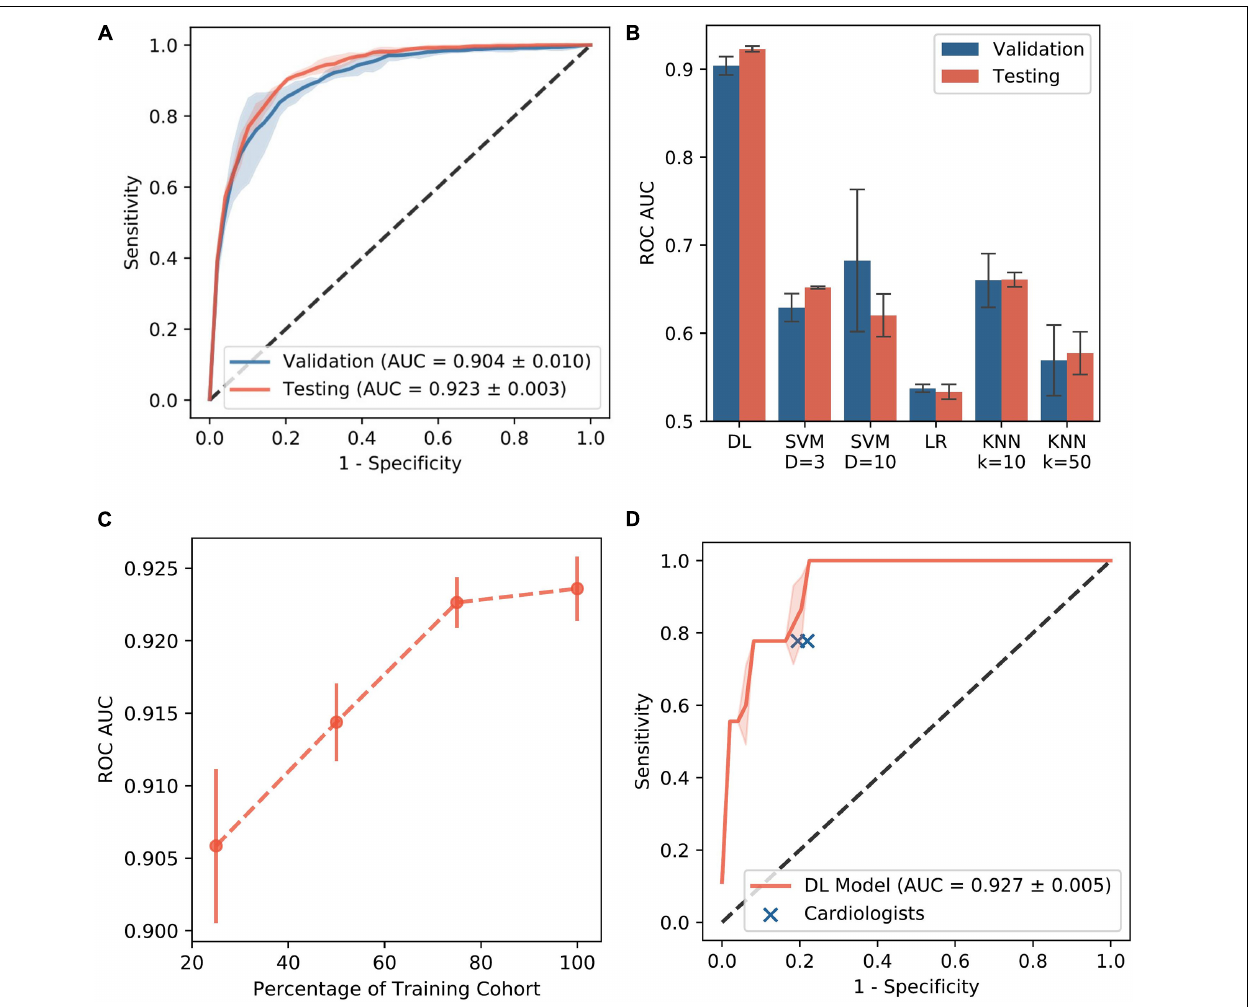
FIGURE 4 | Performance of DL Model. (A) ROC curve is shown for FaST classification using DL model in the validation and testing cohorts. (B) ROC AUC is shown for DL and classic machine learning models. The error bars indicate standard deviation of different random seeds. (C) ROC AUC for DL is shown as a function of the training cohort size. (D) ROC curve is shown for FaST classification using DL model in a random sample of 50 periodic unipolar EGMs. The performance of two cardiologists for FaST re-classification is also plotted for comparison. AUC – area under curve; KNN – k nearest neighbor (either 10 or 50); LR – logistic regression; ROC – receiver operator characteristic; SVM – support vector machine (D refers to polynomial